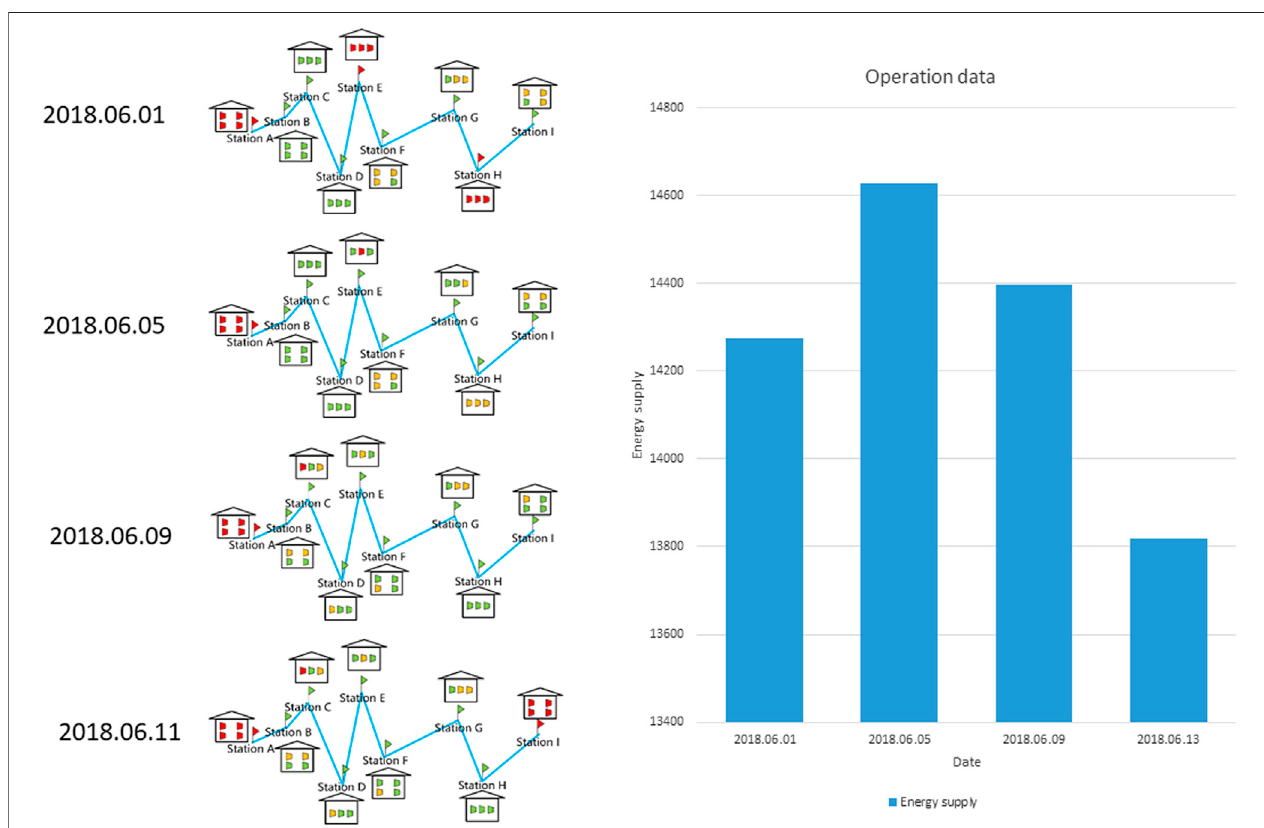
FIGURE 5 | Compressor operations and the corresponding energy supply via the